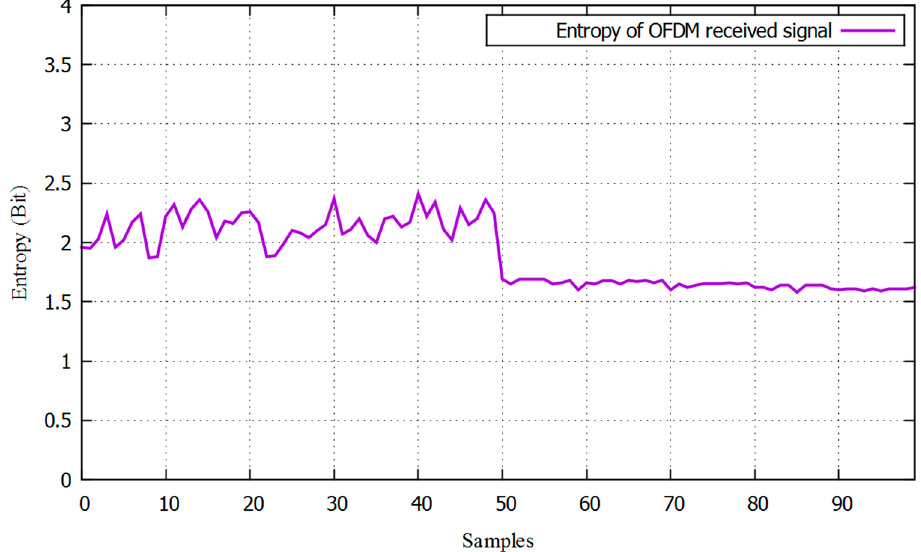
Figure 10. Entropy with and without of the orthogonal frequency division multiplexing (OFDM) signal.